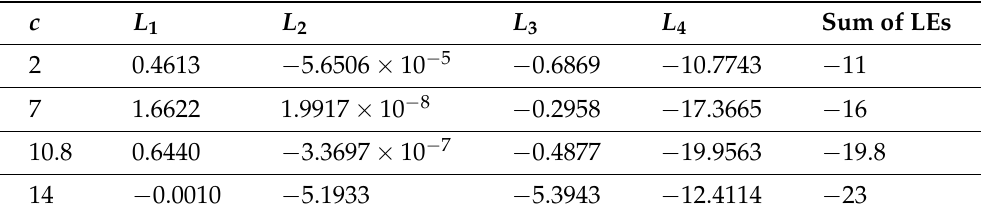
Table 3. The Lyapunov exponents for different c